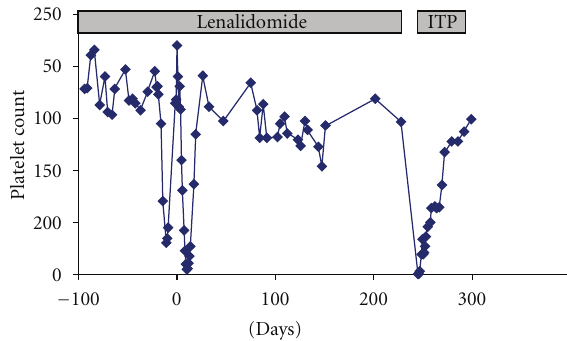
Figure 1: Trend of platelet counts, day 0 represents autologous stem cell